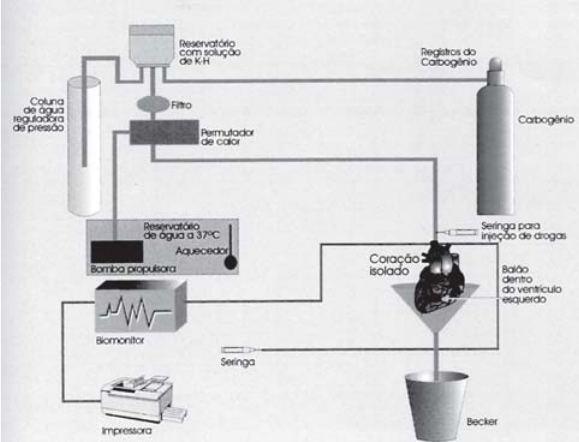
Fig. 1 - Desenho esquemático do sistema descartável de estudo de coração isolado pelo método de Langendorf. A solução de perfusão de Krebs-Hensleit é pressurizada pelo borbulhamento de carbogênio no reservatório. Sob uma pressão mantida em 100 cm de água, a solução perfunde o coração isolado com temperatura de 37+0,5°C após passar pelo permutador de calor. Um balão de látex é posicionado dentro do ventrículo esquerdo, com pressão diastólica mantida em 8+2 mmHg, para monitorização da contratilidade e registro em impressora. Uma via de infusão de drogas é posicionada anteriormente ao coração